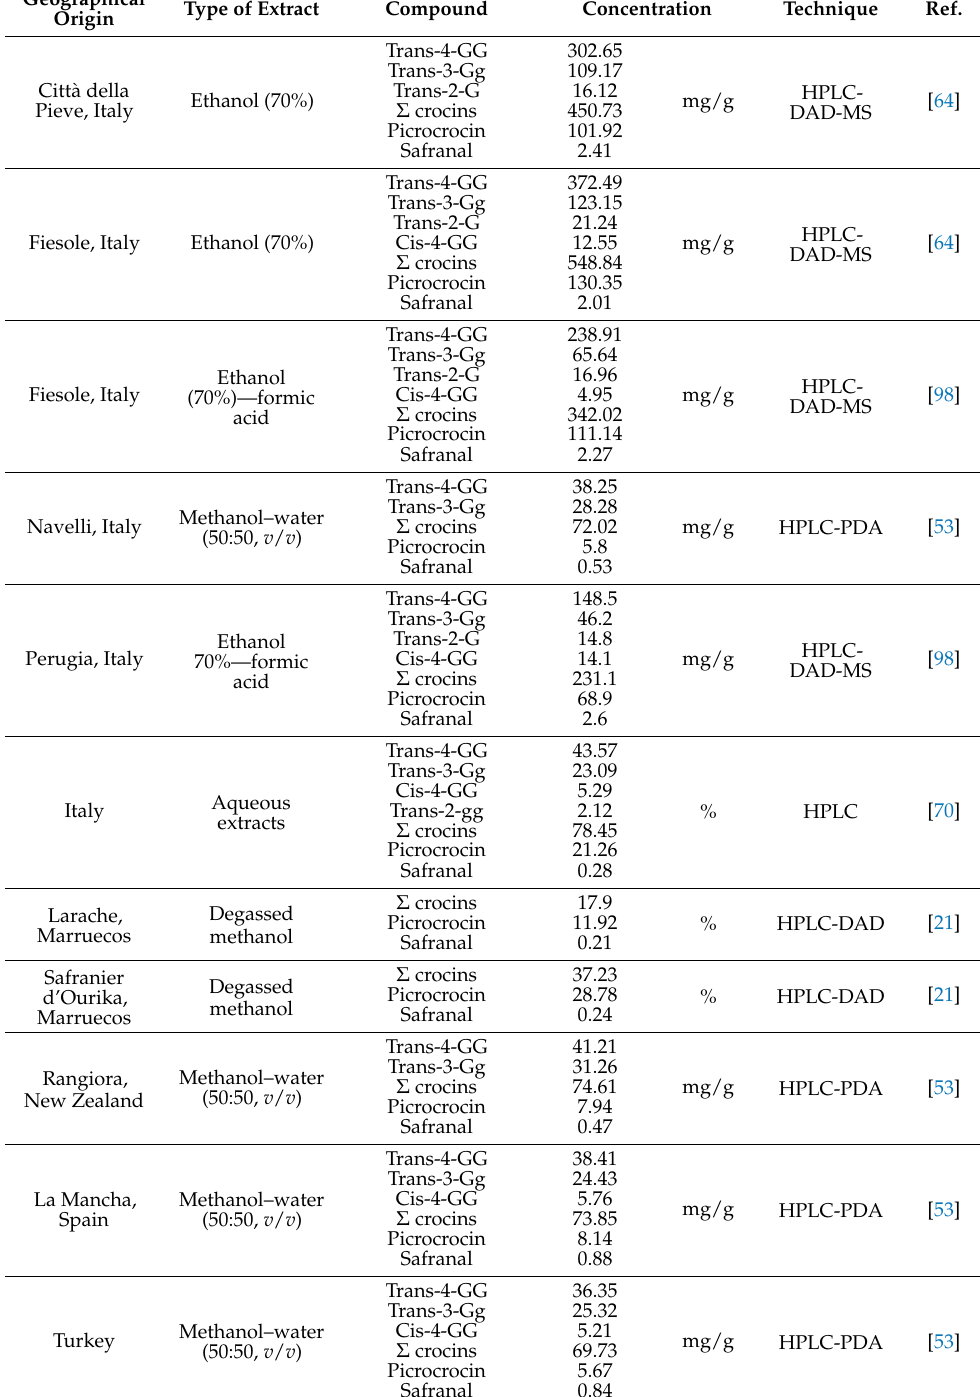
Table 1. Cont. Geographical Origin Type of Extract Compound